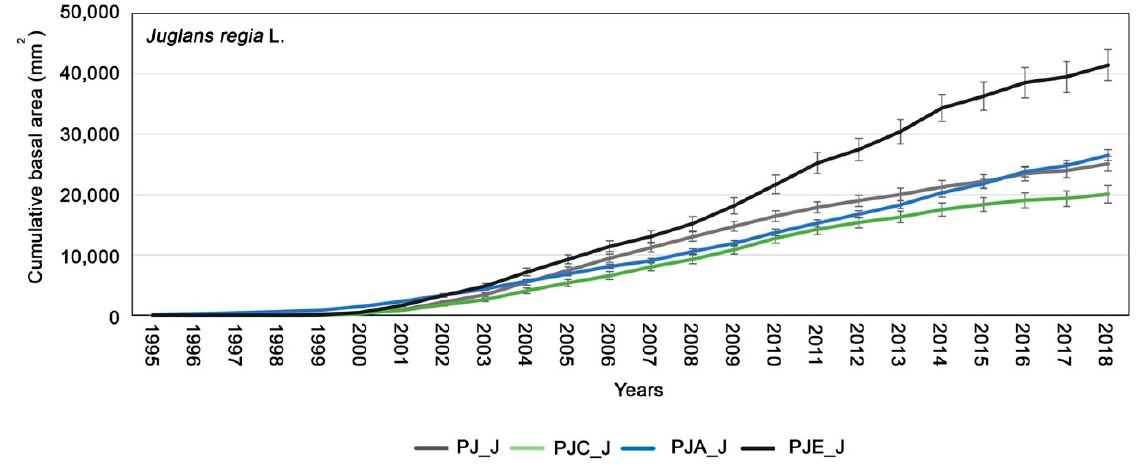
Figure 5. Cumulative basal area (CBA) calculated for Juglans regia in the different systems: PJ_J in gray, PJC_J in green, PJA_J in blue, and PJE_J in black. The bars indicate the standard error. Differences between intercropping systems were evaluated according to one-way ANOVA, using Student–Newman–Keuls coefficient for comparison tests ( p < 0.05).